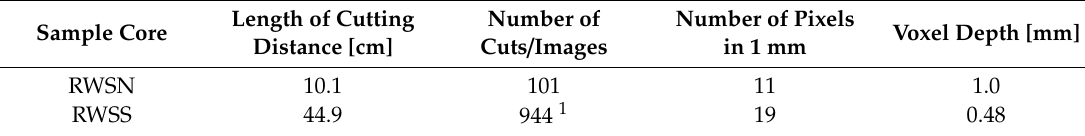
Table 1. Spatial measures of cores cut with DAMOCLES.